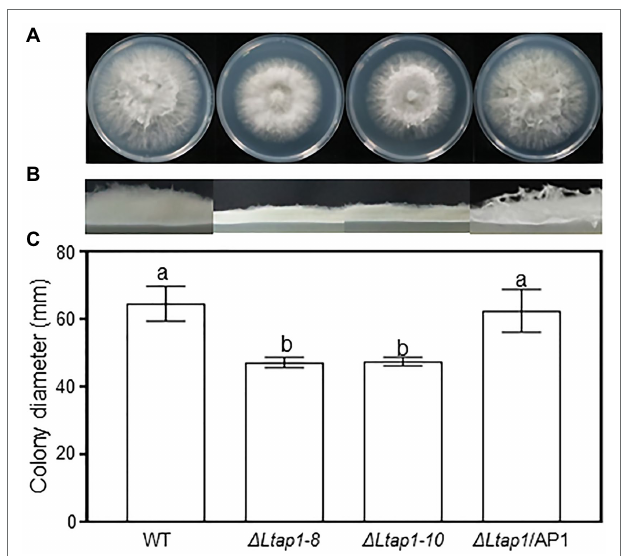
FIGURE 1 | Effect of LtAP1 deletion on the mycelial growth of Lasiodiplodia theobromae . Morphological visualization of fungal colony (A) , aerial hyphae growth (B) , and diameter quantification (C) of the colony growth of WT (wild type), two Δ Ltap1 deletion mutants ( Δ Ltap1-8 and -10 ), and the Δ Ltap1/ AP1 complementary strain after 36 h at 28 ° C in darkness. Different letters on top of bars represent a statistically significant differences at p < 0.05. Bars show mean growth averaged across three biological replicates, and error bars represent standard